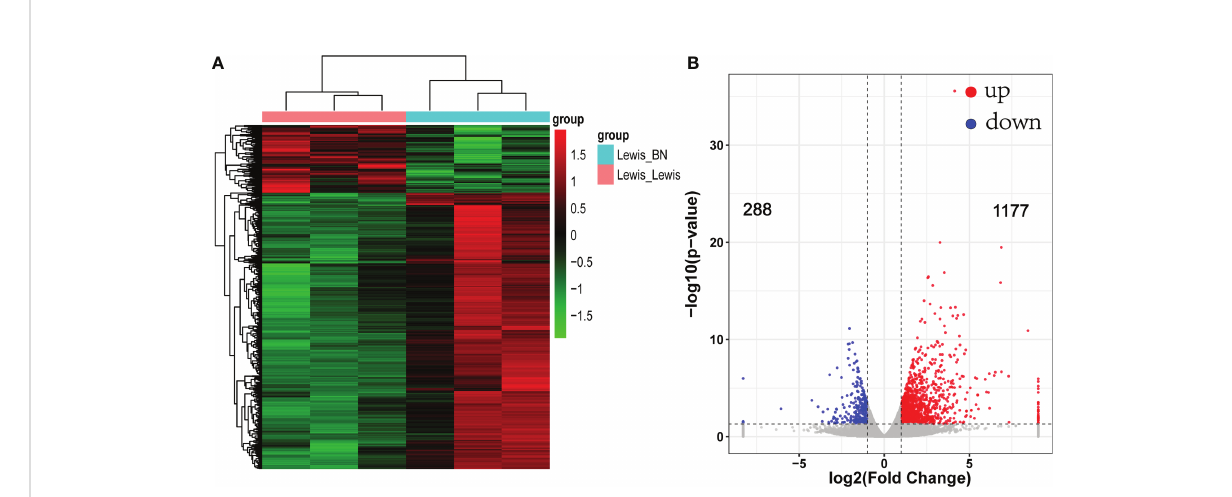
FIGURE 2 Heat map and volcano map of differentially expressed genes (DEGs). (A) Each column represents a sample. Red indicates up-regulated genes; green indicates down-regulated genes. (B) Volcano map of DEGs. fold change >2 or < − 2, FDR <